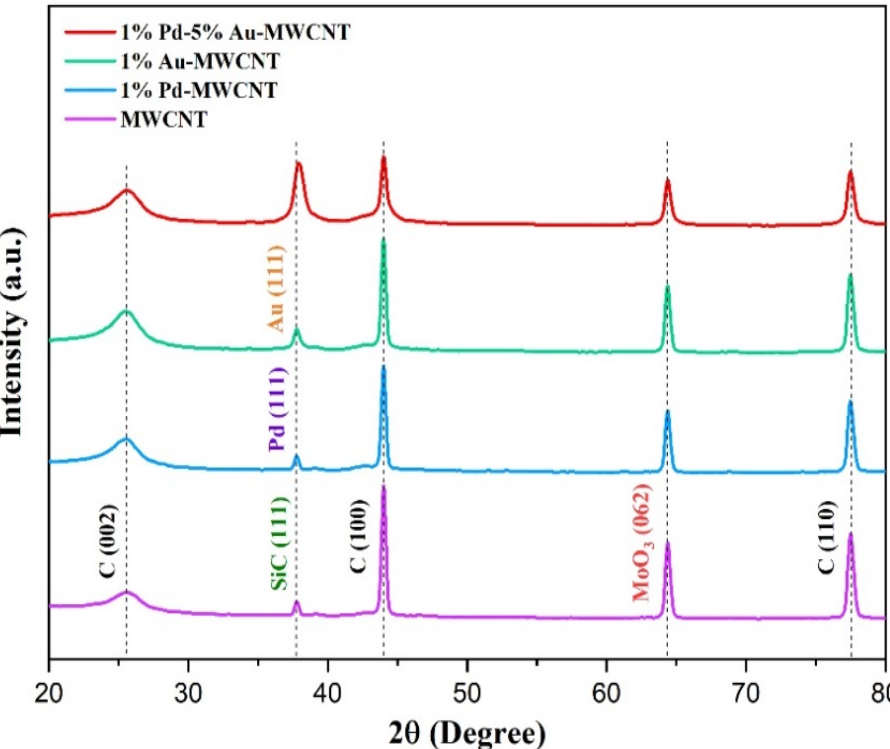
Figure 2. XRD patterns of the various kinds of sensing materials samples.